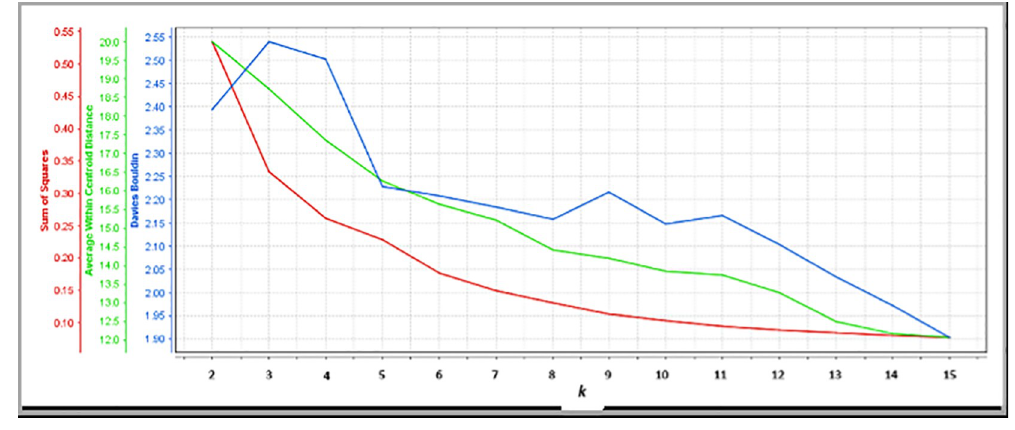
Fig 2. Cluster performance